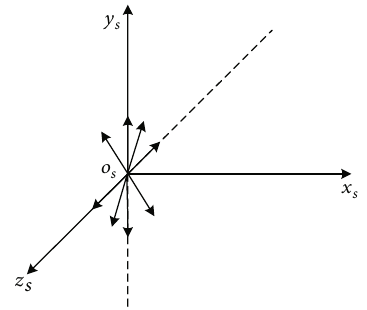
Figure 3: The discrete action space diagram.